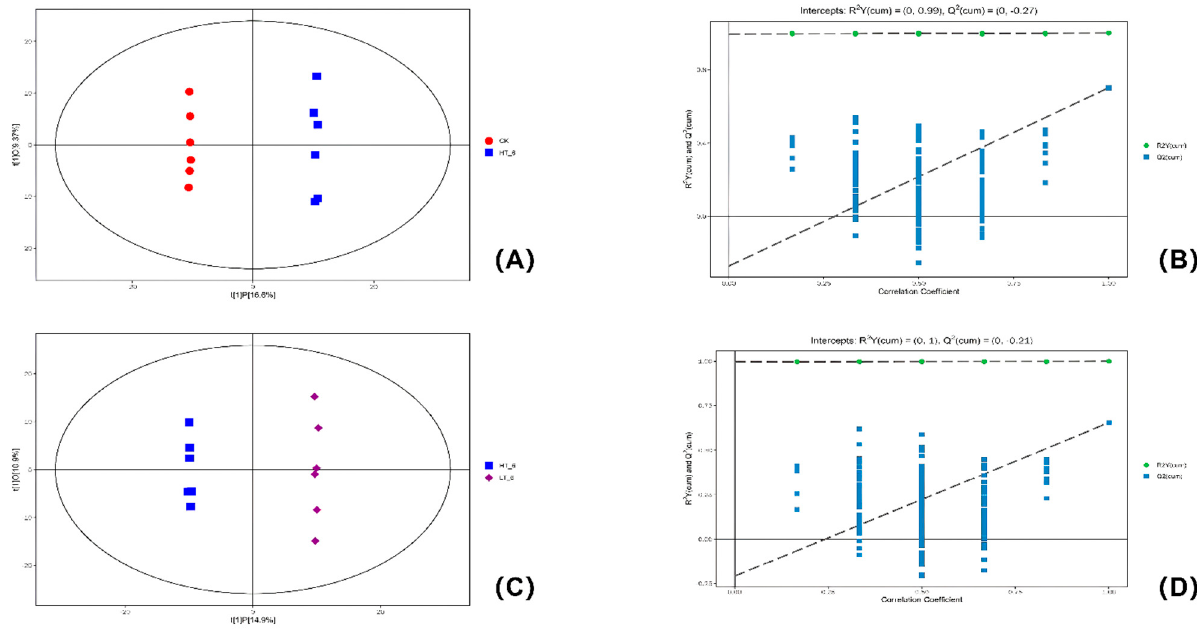
Figure 4. The scatter plot and permutation tested results of the OPLS-DA model for the HT_6 vs. CK groups, and the HT_6 vs. LT_6 groups. ( A ) The scatter plot of the OPLS-DA modeled on the HT_6 vs. CK groups; ( B ) The permutation test of the OPLS-DA modeled on the HT_6 vs. CK groups; ( C ) The scatter plot of the OPLS-DA modeled on the HT_6 vs. LT_6 groups; ( D ) The permutation test of the OPLS-DA modeled on the HT_6 vs. LT_6